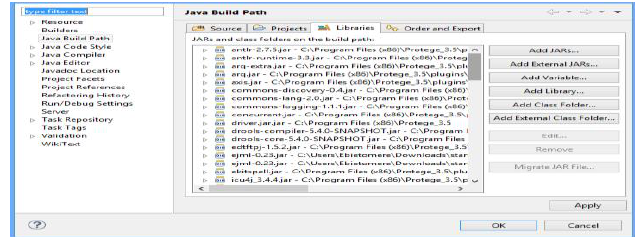
Fig. 10. Law-Torch component integration build